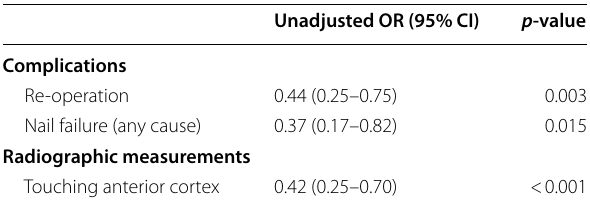
Table 5 Unadjusted associations of long Affixus vs long